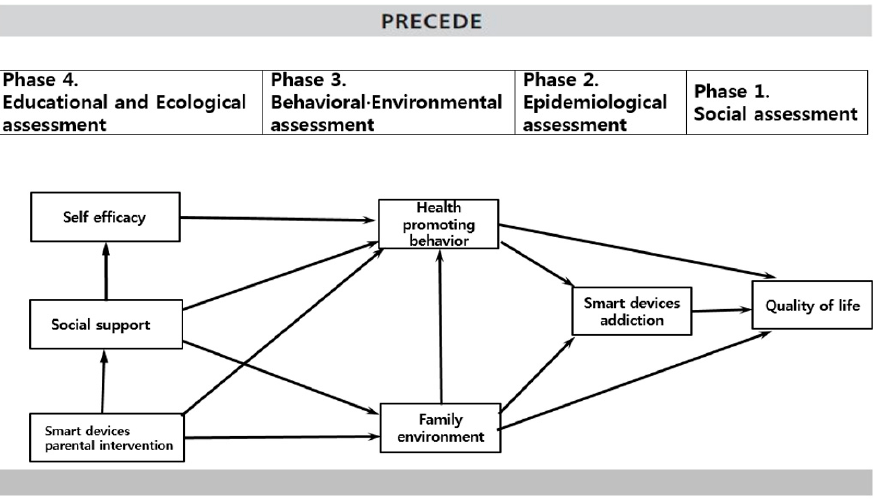
Figure 1. Concept of the study applying the PRECEDE model.